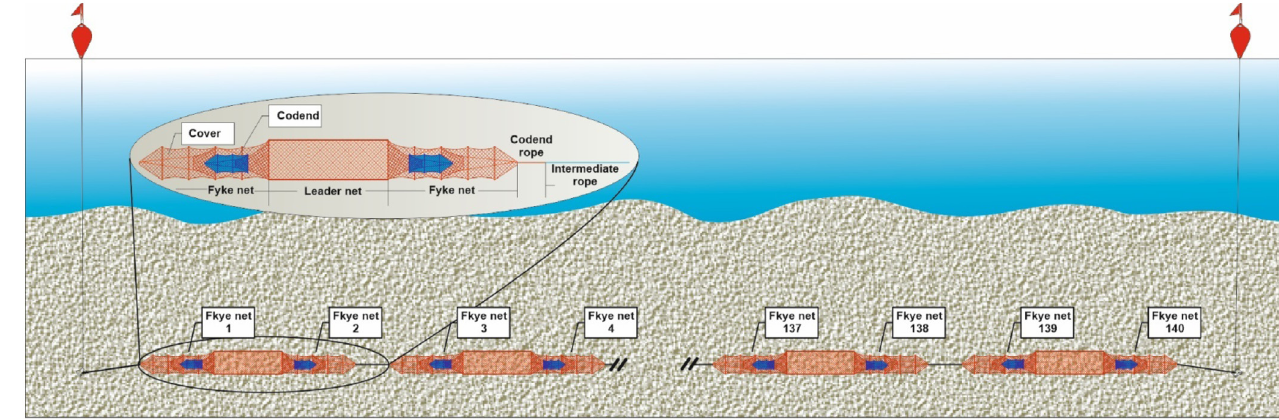
Fig. 2. General view of combined experimental fyke nets on the lake